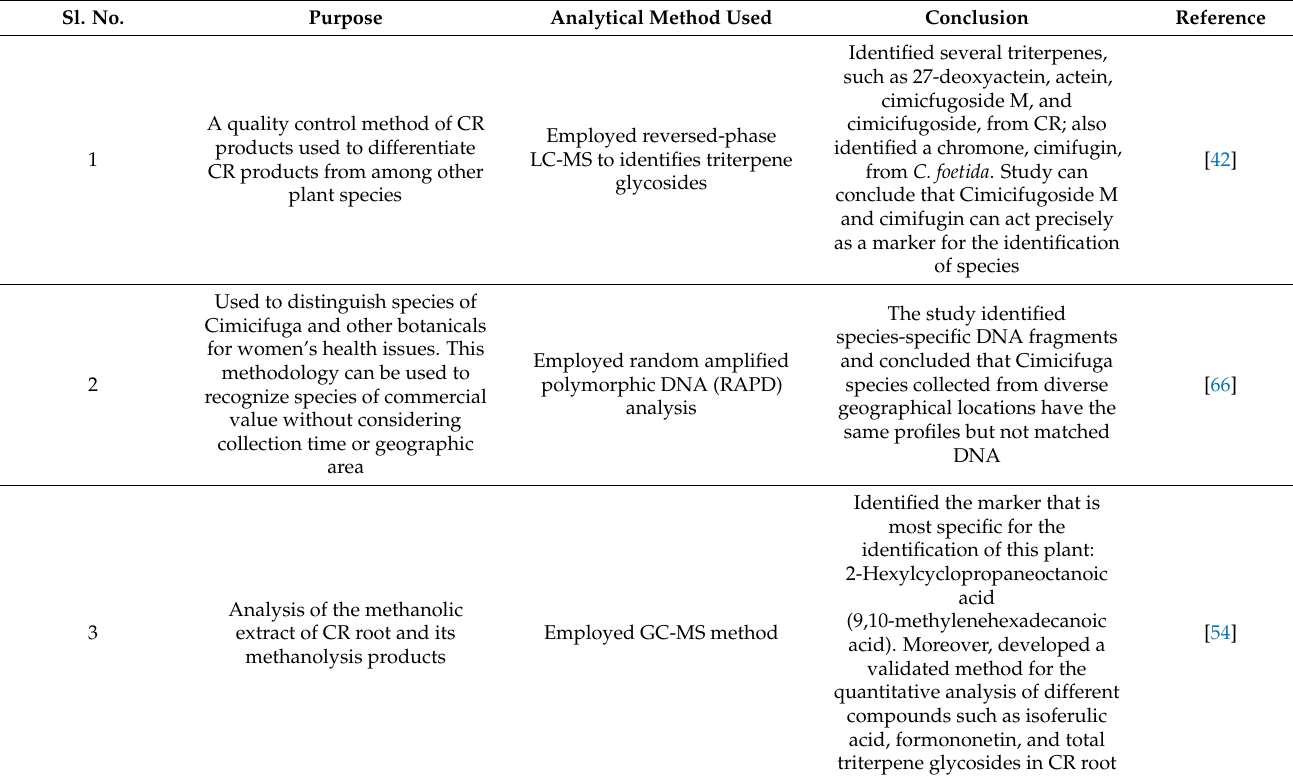
Table 5. Different quality control methods available for